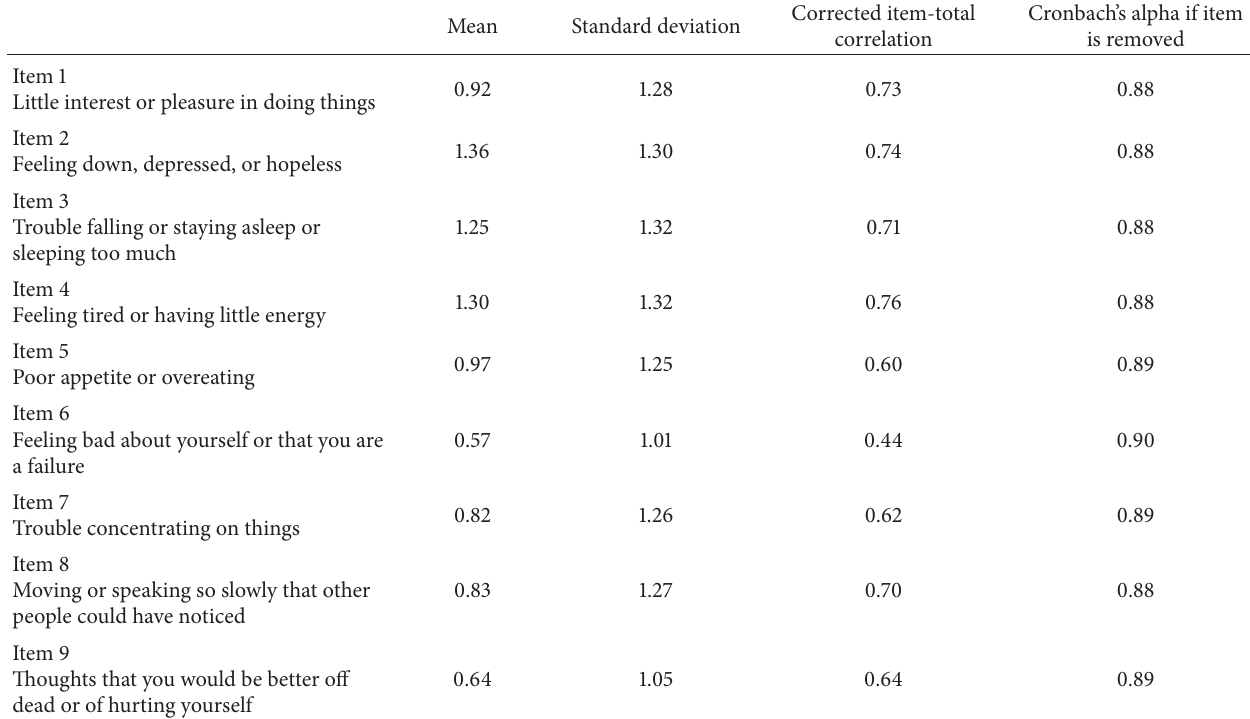
Table 4: PHQ-9 item mean and item-rest